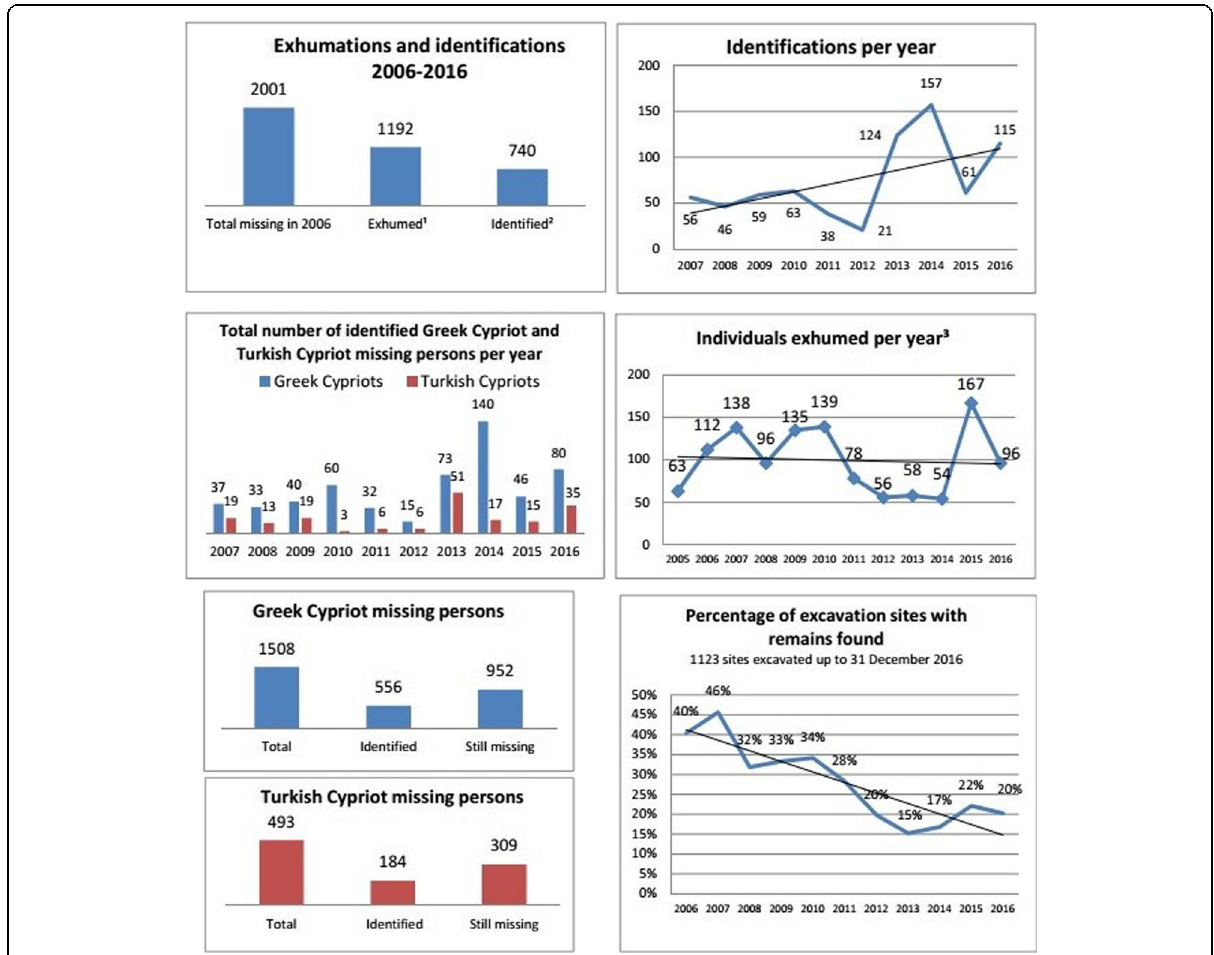
Fig. 7 The statistics on annual exhumations, identifications, and the recovery rate of human remains, and the identified missing